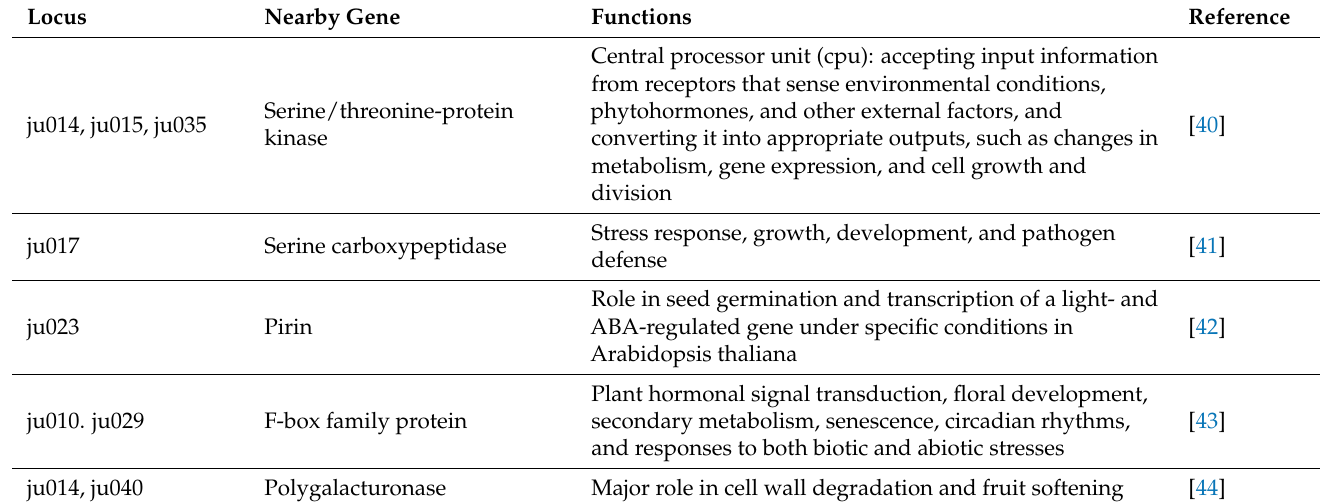
Table 4. Potential SSR markers and nearby